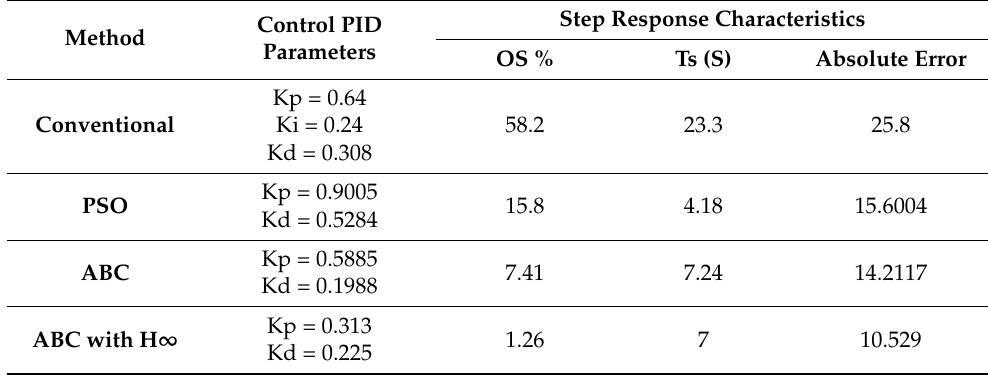
Table 1. Step response characteristics of different